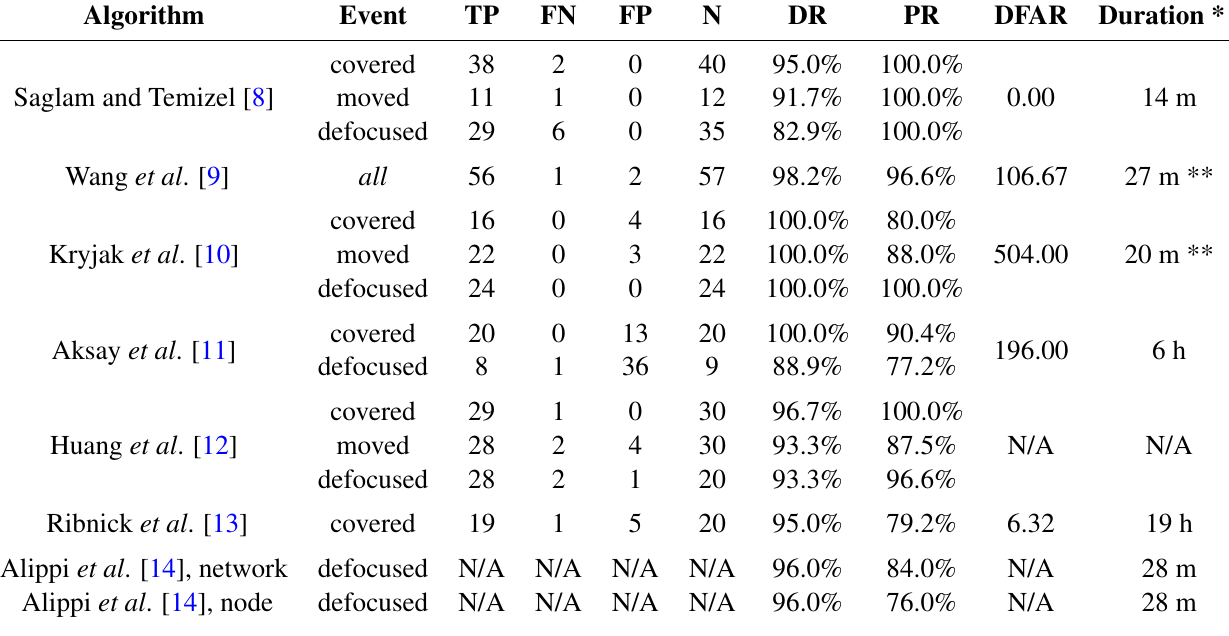
Table 4. Accuracy of the conventional tamper detection algorithms. PR, precision rate.